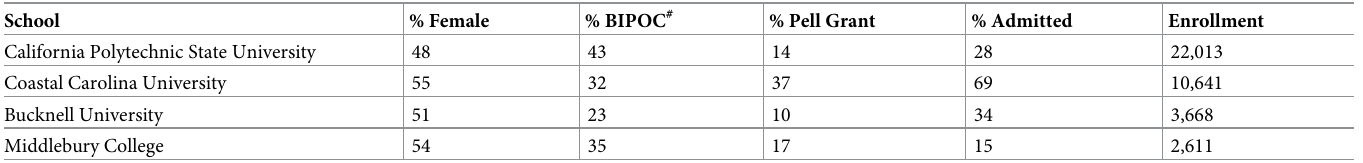
Table 1. Institutional characteristics �